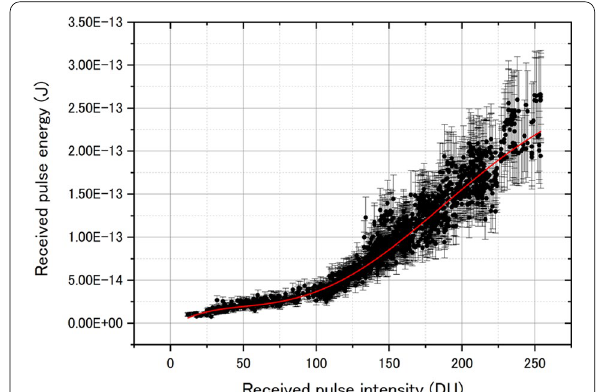
Fig. 8 E obs and D R . The fifth polynomial equation is fitted to the data (red